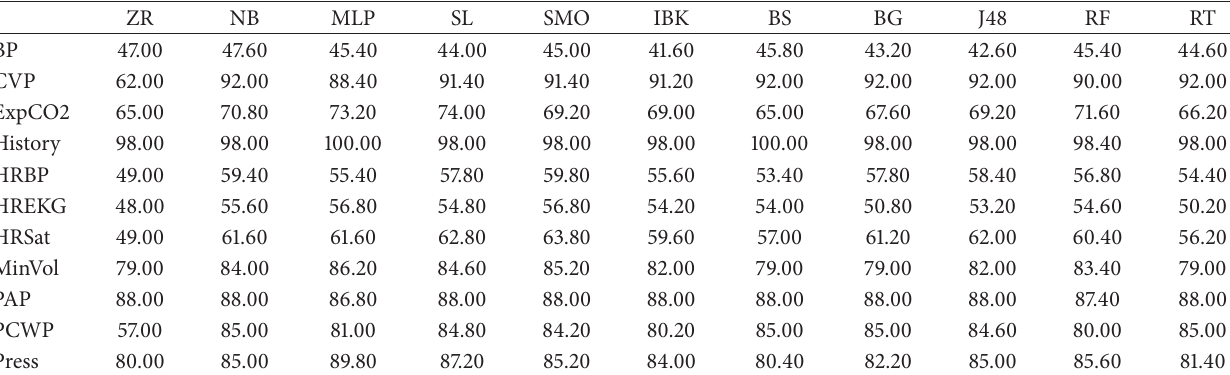
Table 5: Classification accuracies with datasets having 100 samples (%).